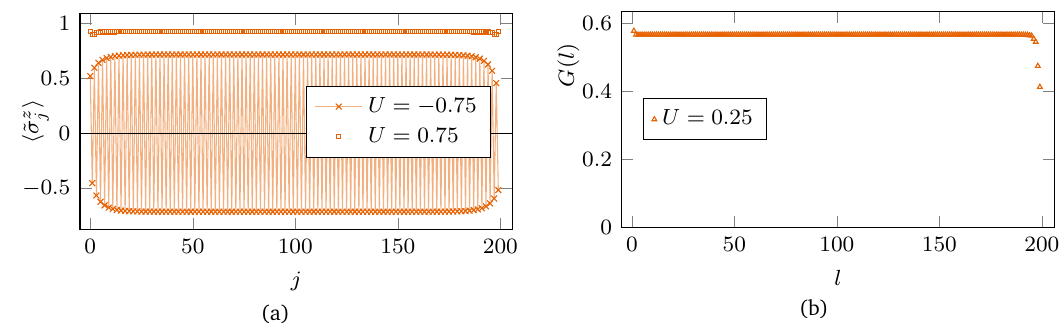
Figure 11: Example points displaying the respective order for the various gapped phases for f = − 3. (a) The antiferromagnetic ( U = − 0.75) and ferromagnetic ( U = 0.75) behaviour of the local magnetisation. (b) The correlation function (37) / topological order. All data for L = signalling (cid:90) 3